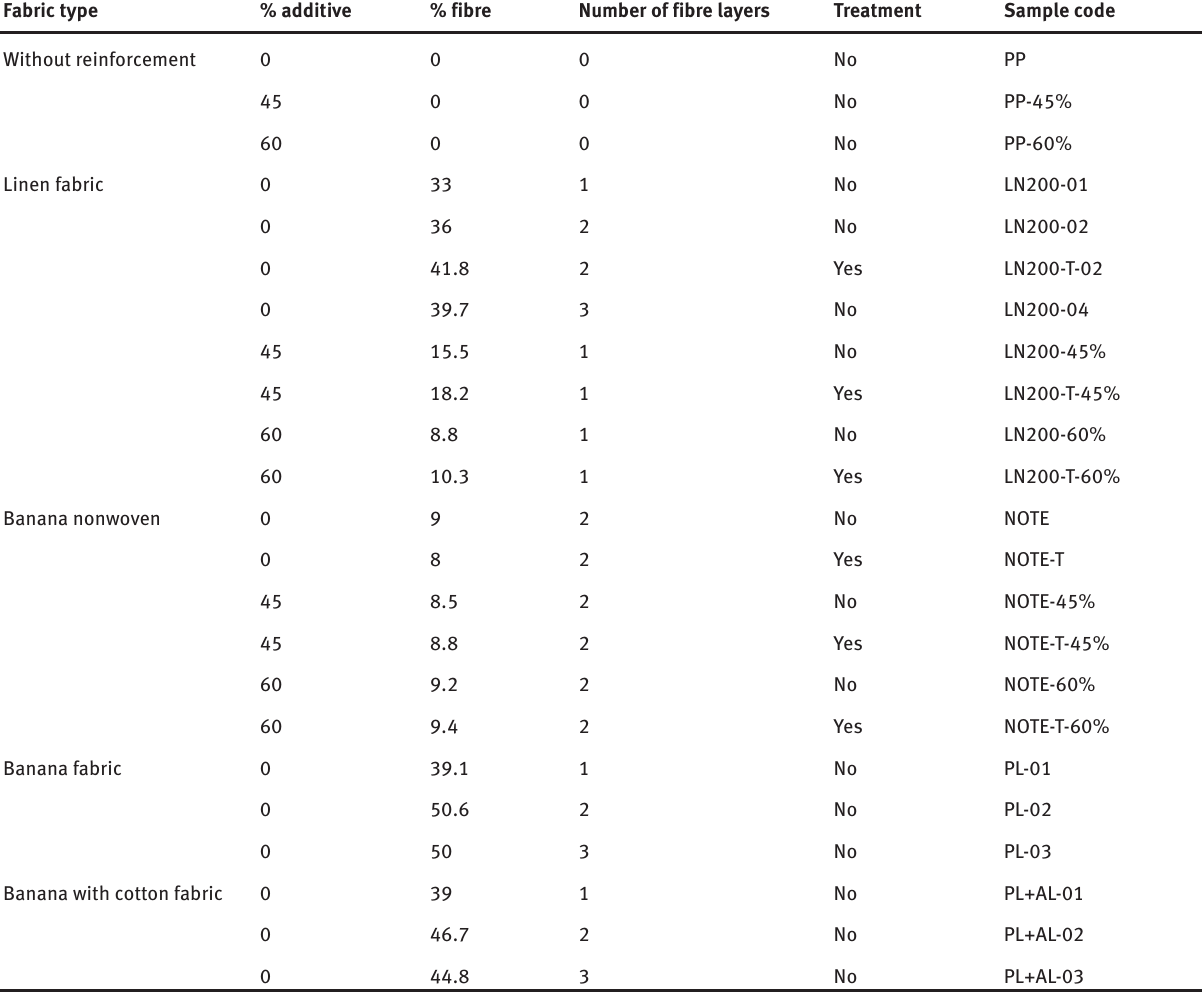
Table 1: Formulations included in the study. Fabric type